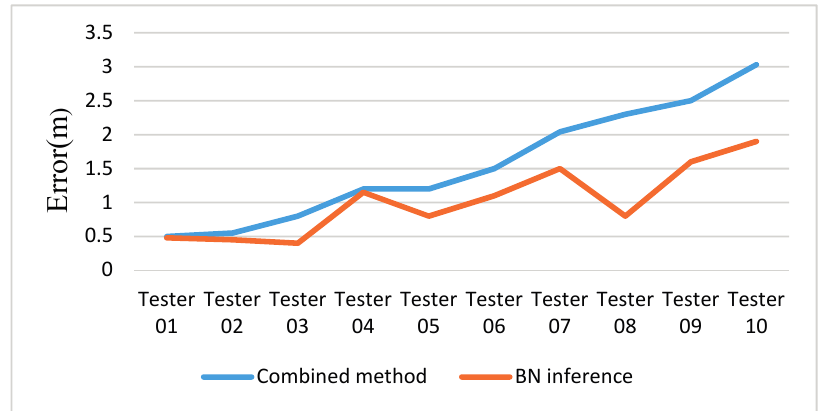
Figure 13. Experiment results of altitude error in a total distance of 100 m with ten testers at normal speed.